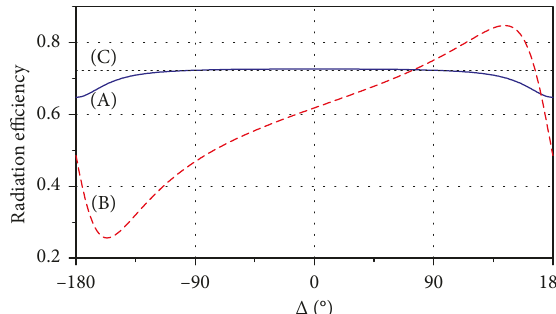
Figure 2: Efficiency vs. phase Δ for both arrays: (A) BSA, (B) EFA, and (C) for a single dipole.